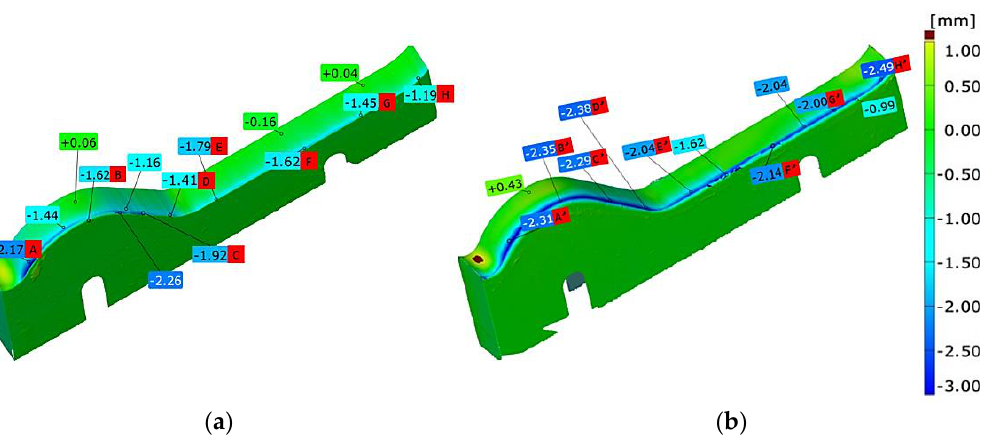
Figure 5. Results of 3D scanning: ( a ) Hardox 600 after 400 h of work and ( b ) NC11LV after 900 h of